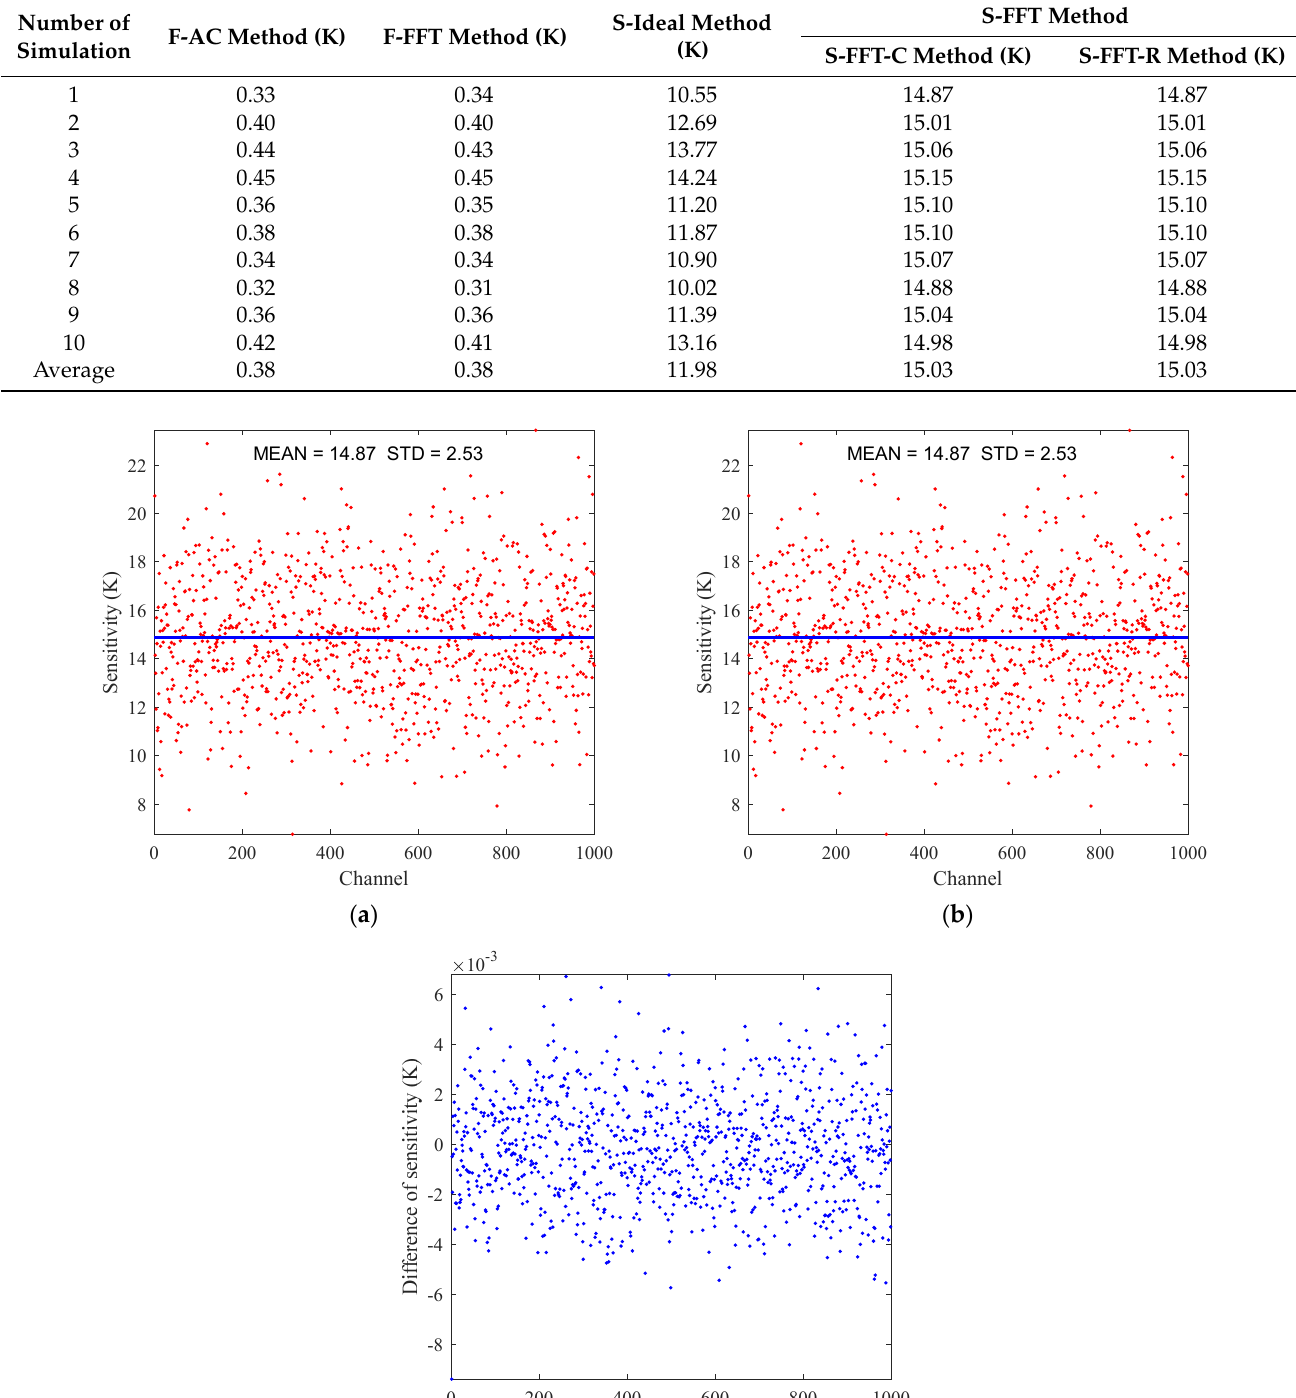
Table 4. The sensitivity of the four methods obtained from simulations.